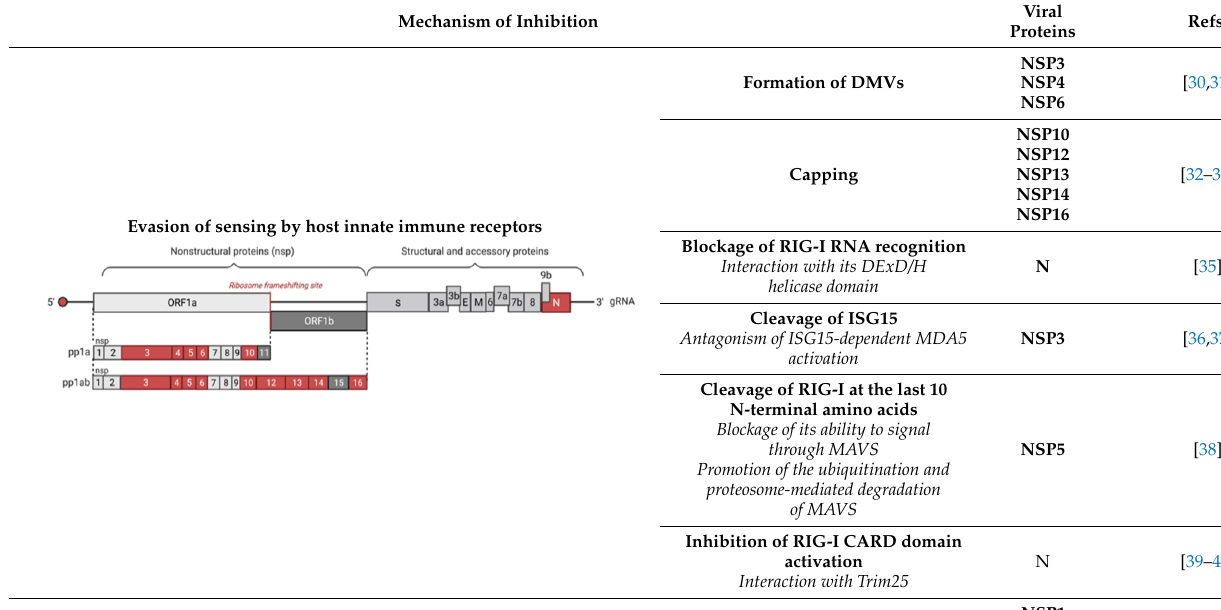
Table 1. Summary of mechanisms applied by SARS-CoV-2 to antagonize innate immune responses. The SARS-CoV-2 genome organization is represented, and proteins involved in host innate immunity pathway regulation are colored in red.